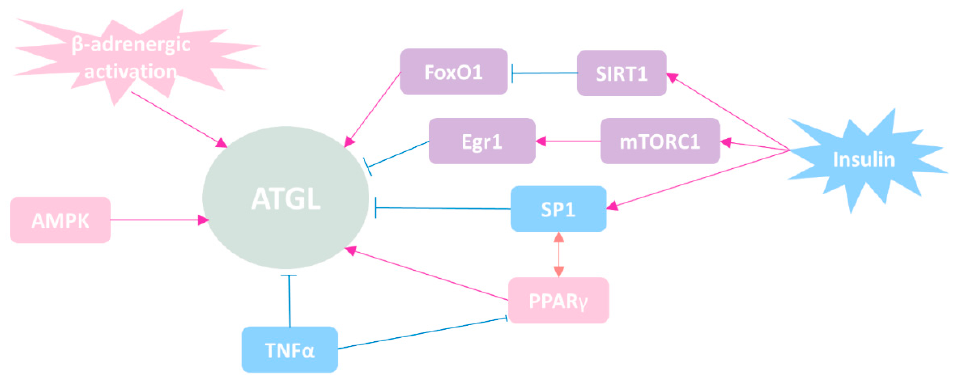
Figure 2. Simplified overview of regulation of ATGL expression. ATGL is demonstrated to be activated by β -adrenergic activation. AMPK phosphorylates ATGL at Ser 406 therefore activates its enzymatic activities. Insulin inhibits ATGL expression through upregulating SIRT1, which restrains the nuclear localization of FoxO1 by deacetylating. Insulin also inhibits ATGL expression through Egr1-mTORC1 signaling pathway. Sp1 has an inhibitory control over ATGL in preadipocytes, while the functional interaction of PPAR γ and Sp1 transactivates ATGL in mature adipocytes. TNF- α downregulates ATGL mRNA level but does not alter its protein level.